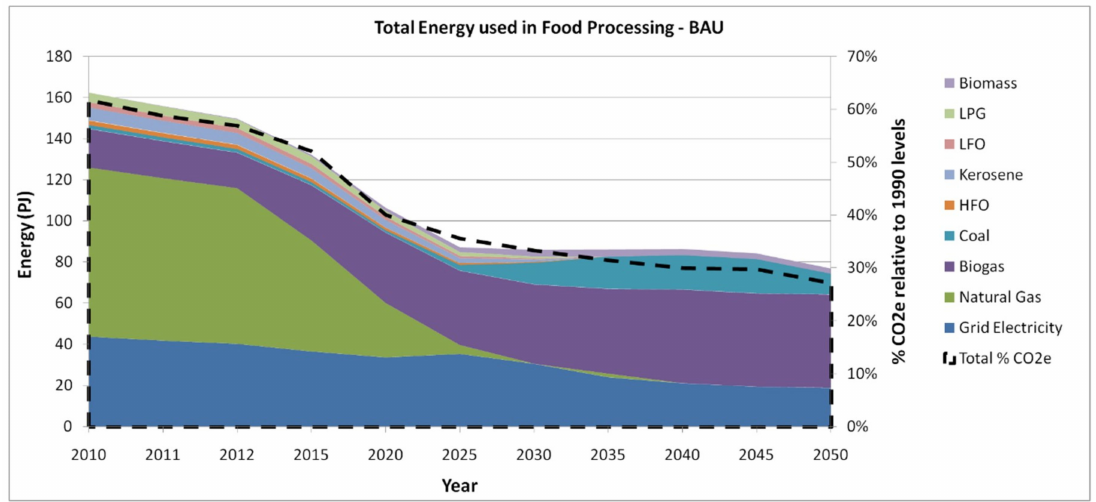
Figure 5. Energy consumption and emissions for the Business As Usual (BAU) scenario